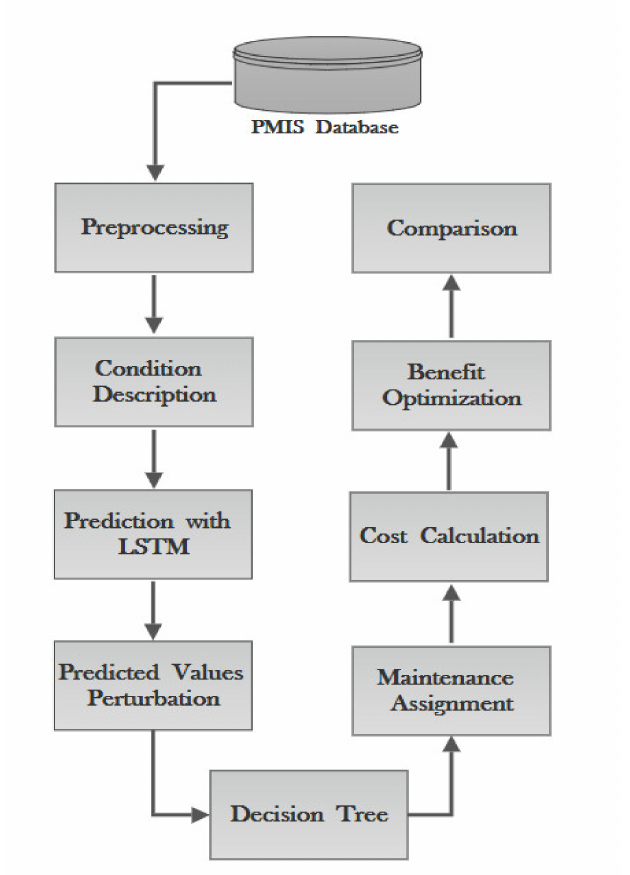
Figure 2. Research steps.